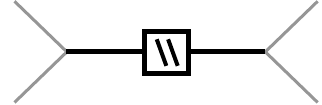
Figure 2.32: The Process Description glyph for omitted process .